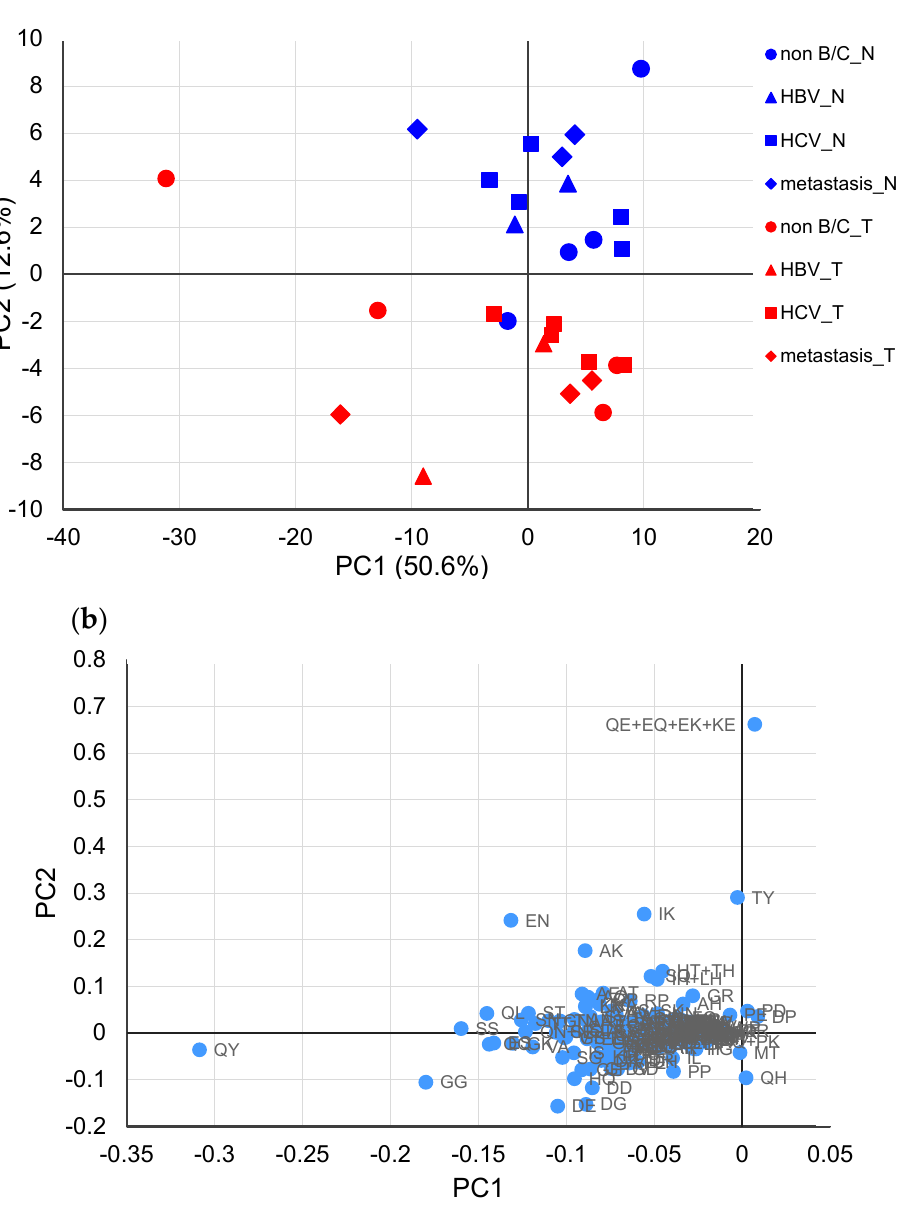
Figure 2. Principal component analysis (PCA) using the Pareto-scaled dipeptide data. ( a ) PCA score plots of paired nontumor (blue) and tumor (red) tissues in different types of liver cancers. The contribution ratios were 50.6% and 12.6% for PC1 and PC2, respectively. ( b ) PCA loading plots of dipeptides on the first two principal components.